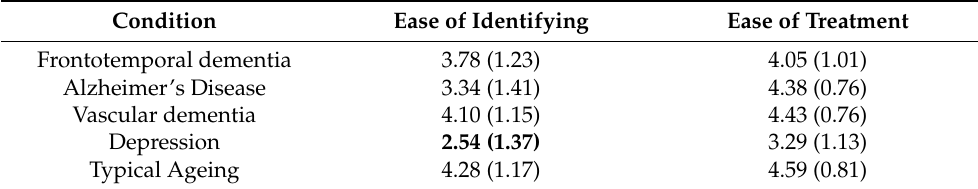
Table 4. Ratings from 1 to 5 given to questions on the ease of identifying and treating (Mean and SD). Condition